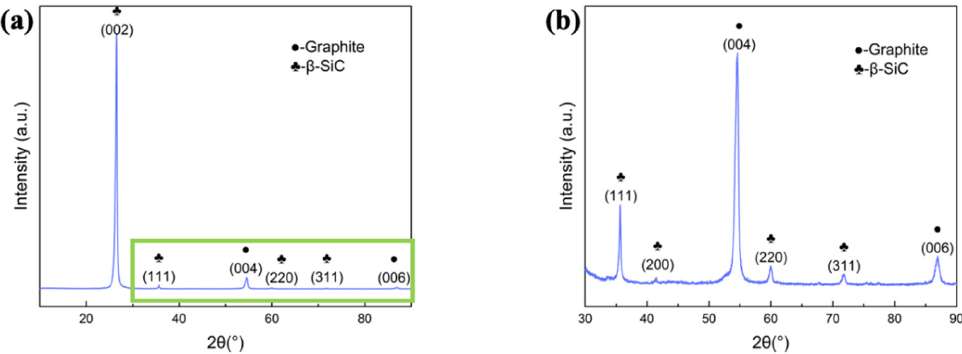
Figure 4. ( a ) TEM image of AD-3 sample, ( b ) HRTEM image of SiCNWs, ( c – f ) elemental mapping of sample AD-3.